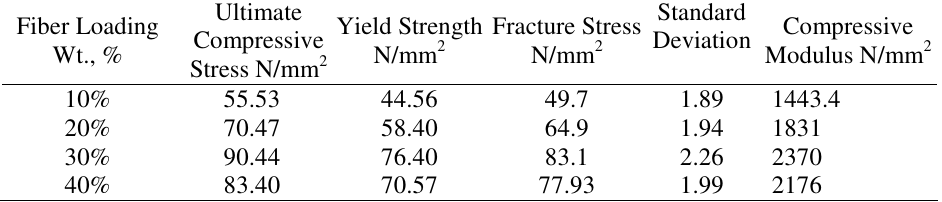
Table 2. Parameters obtained from compressive stress-strain curve at different loading.